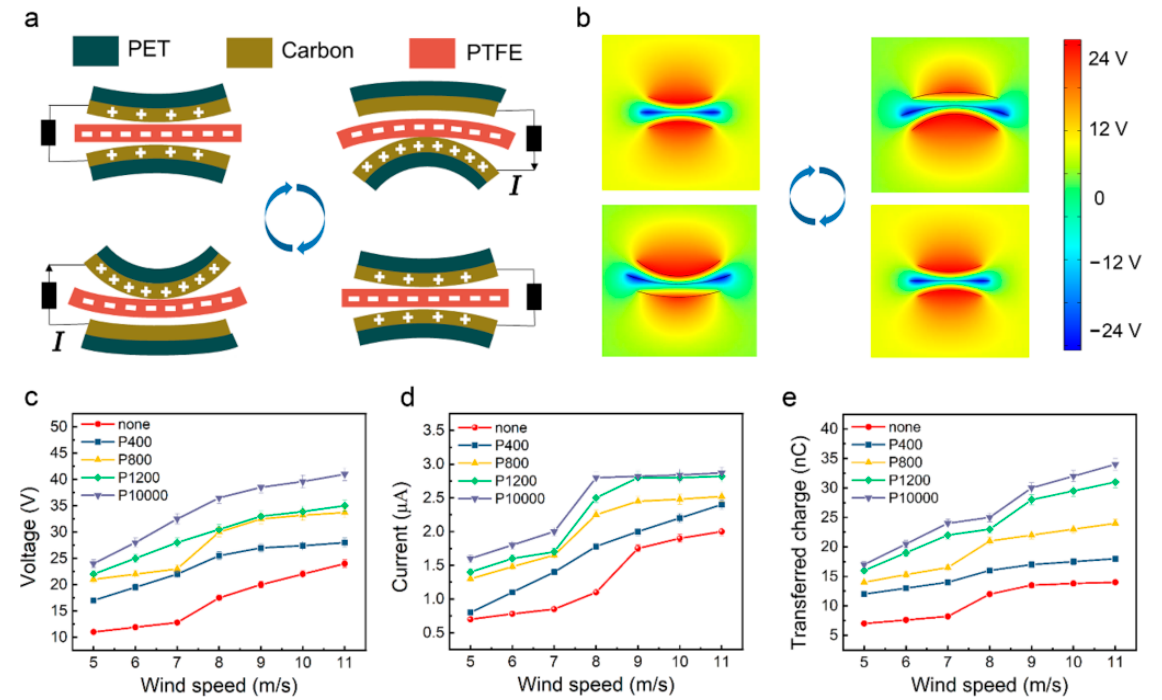
Figure 2. Working principle and grinding-improved output performance of the HF-TENG. ( a ) The working principle of the HF-TENG and the charge distributed in different stages. ( b ) The correspond- ing potential distribution calculated by COMSOL in a two-dimensional plane. ( c ) V OC , ( d ) Isc , and ( e ) Qsc of the HF-TENG under various wind speeds when the PTFE surface is ground with sandpaper of different mesh